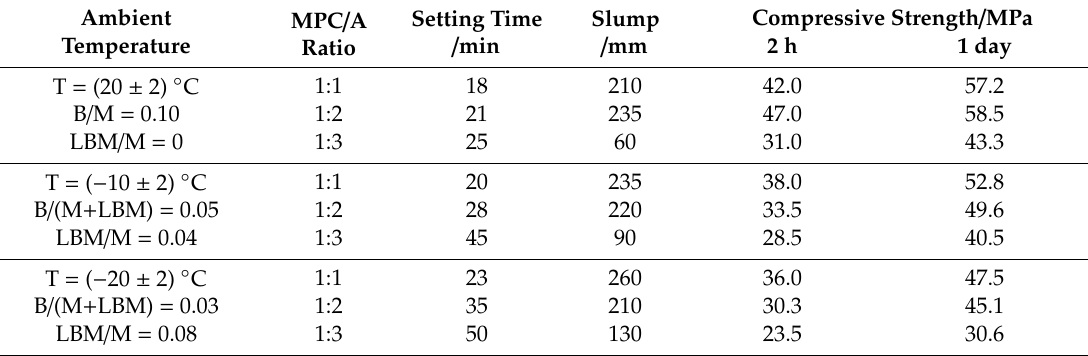
Table 3. The influences of the mass ratio of MPC / A on the physical and mechanical properties of magnesium phosphate cement concrete